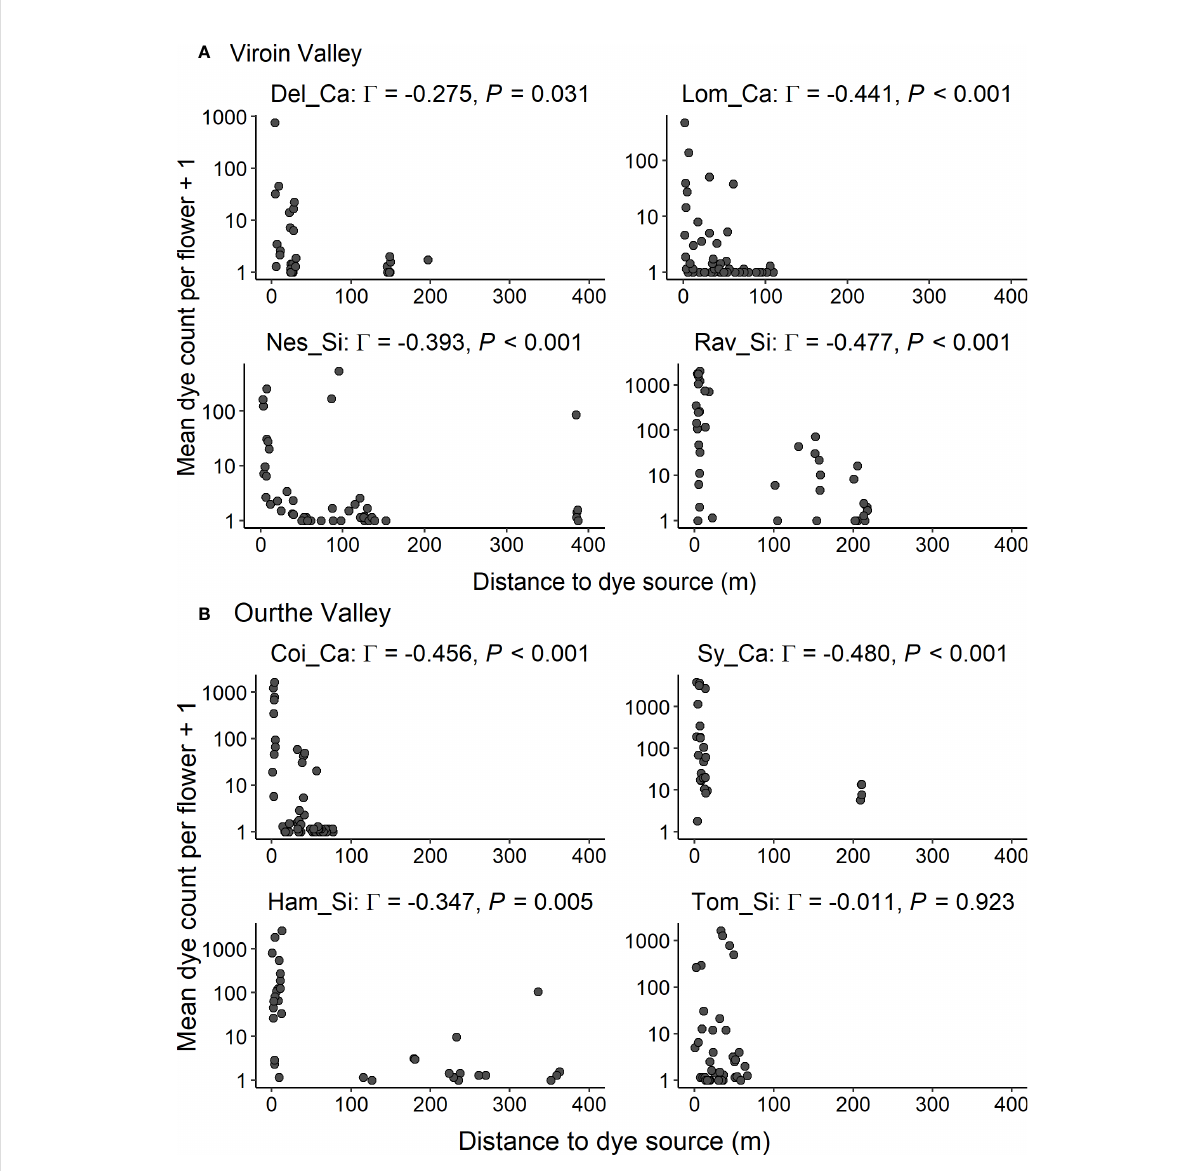
FIGURE 4 Intrapopulation dye transfers: mean dye count per fl ower for each recipient individual (axis in log-scale) in function of the distance to dye source for eight calcicolous (Ca) and silicicolous (Si) populations of Silene nutans in (A) Viroin Valley and (B) Ourthe Valley. G : Gamma correlation coef fi